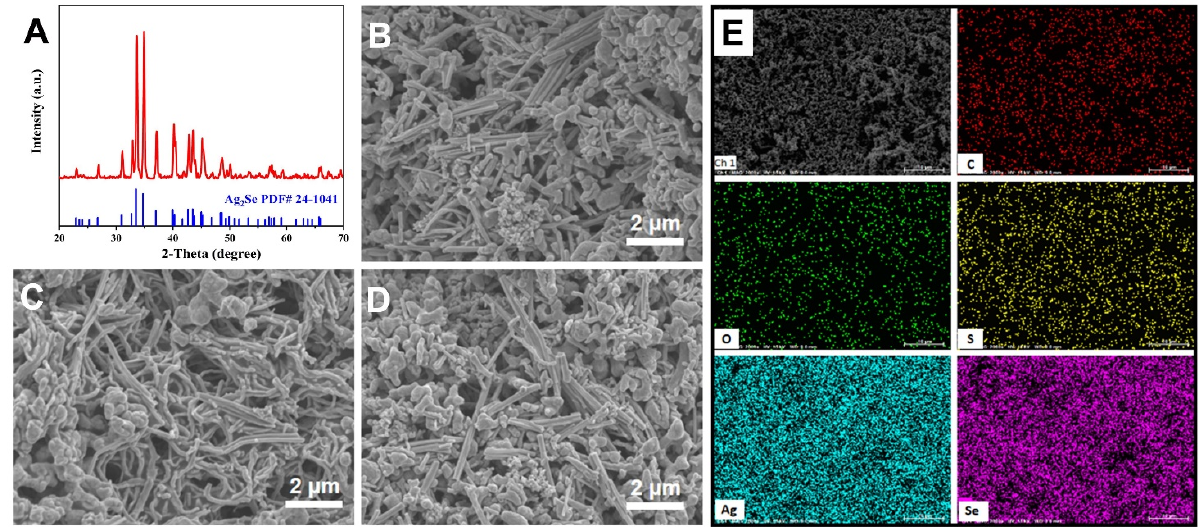
Figure 2. ( A ) The XRD patterns of Ag 2 Se NRs; the FESEM images of ( B ) PI10, ( C ) PI20, and ( D ) PI30; ( E ) the EDS of Ag 2 Se NRs.